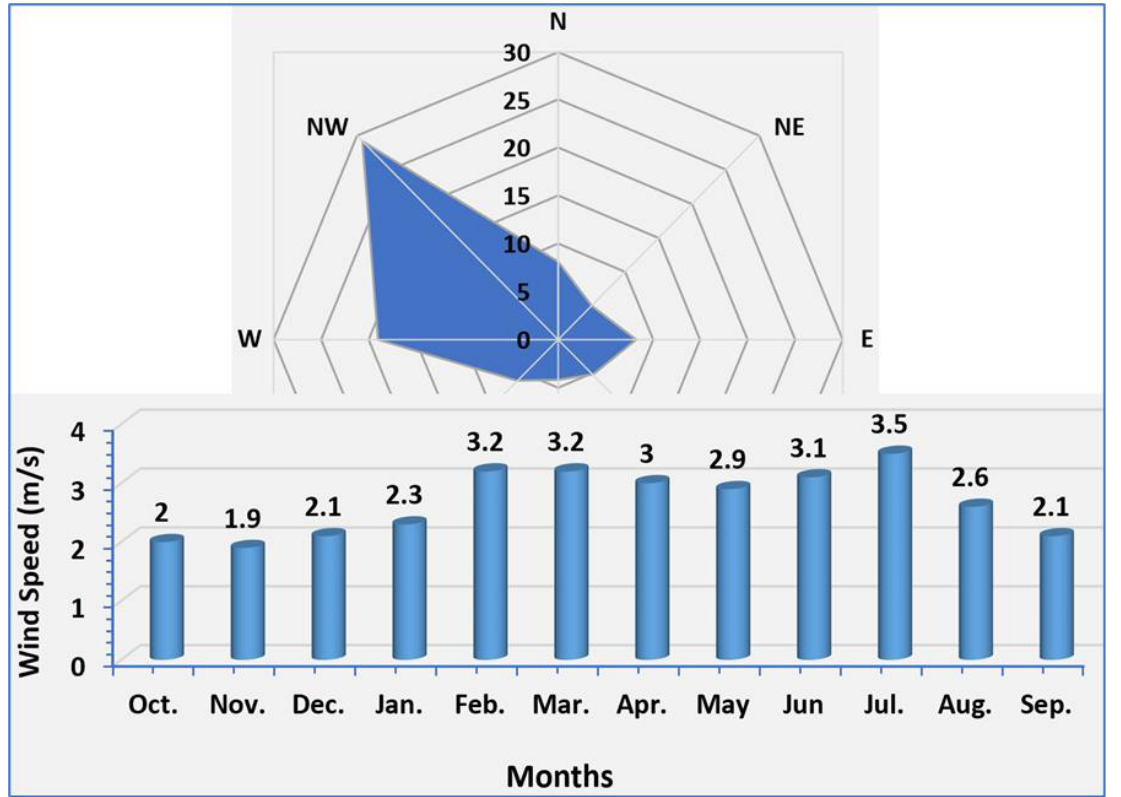
Figure 9. Monthly wind speed averages in Iraq from 1960 to 2020, and a rose diagram showing that west and northwest are the dominant wind directions in Iraq.